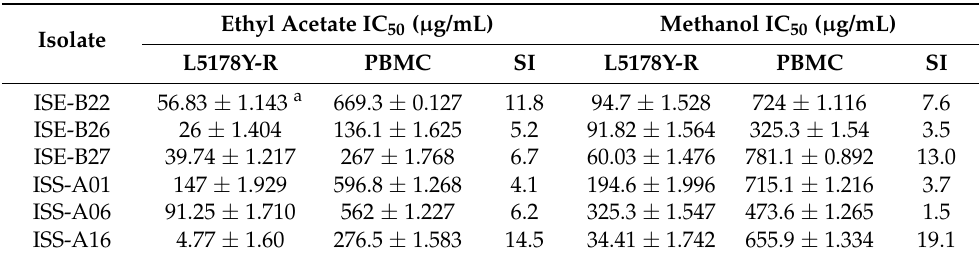
Figure 3. Tumor cell growth inhibition by ethyl acetate extracts from I. sonorae endophytic and rhizosphere bacteria cultures. L5178Y-R cells were placed at a concentration of 1 × 10 4 cells/well and PBMC at 2 × 10 5 cells/well, and treated with ethyl acetate bacterial extracts at concentrations ranging from 15.62 µ g/mL to 500 µ g/mL for 48 h. ( a ) ISE-B22, ( b ) ISE-B26, ( c ) ISE-B27, ( d ) ISS-A01, ( e ) ISS-A06, and ( f ) ISS-A16. Cell growth inhibition was assessed by the MTT reduction assay, measuring OD at 570 nm. Vincristine (VC) was used as a positive control at a concentration of 0.05 µ g/mL, as detailed in the text. VC caused 69.98% and 16% growth inhibition against L5178Y-R and PBMC, respectively. Data represent mean ± SD of triplicates from three independent experiments. * p < 0.05; ** p < 0.01, as compared with untreated control. Table 2. SI and IC 50 of isolated bacterial culture extracts on murine lymphoma L5178Y-R and PBMC growth.